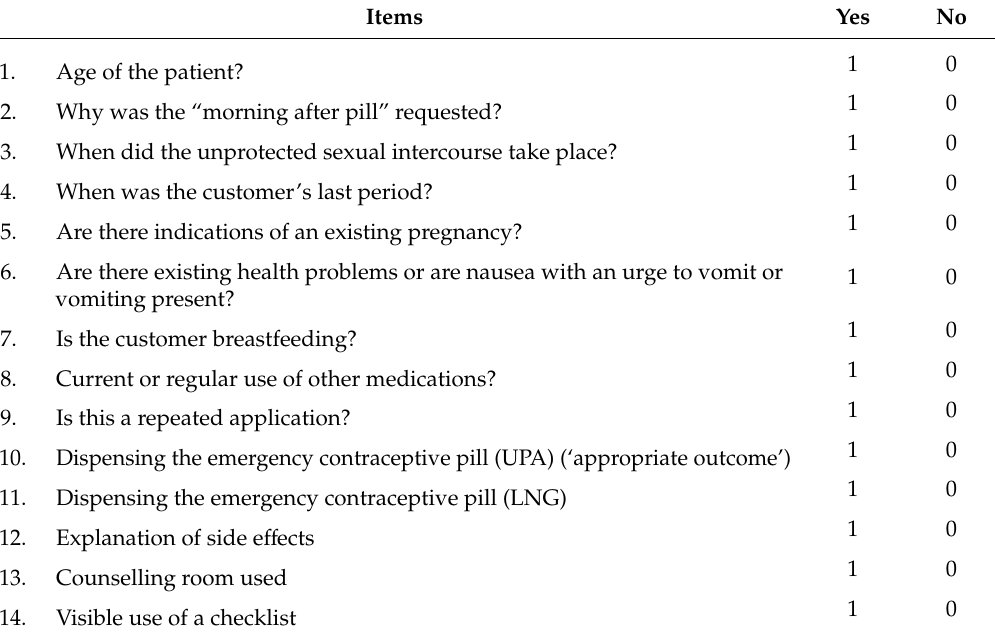
Table 2. Evaluation